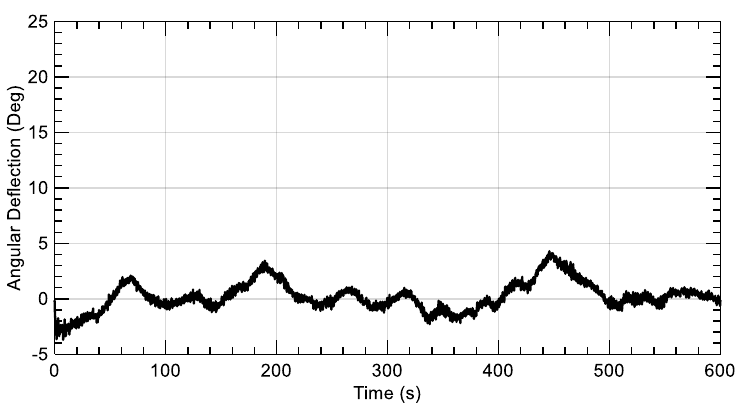
Figure 28. Tower top yawing deflection: turb. class B.